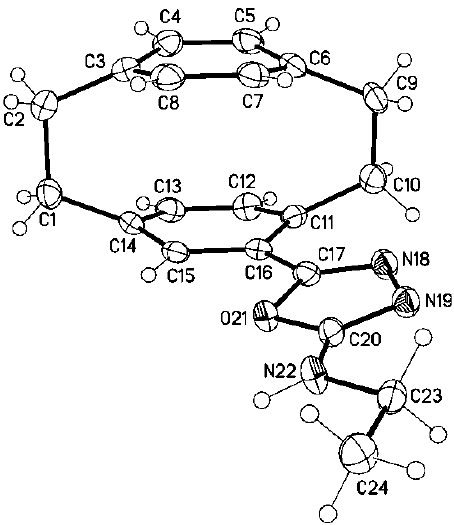
Figure 9. Molecular structure of compound 13c identified according to the IUPAC nomenclature as 5-(1,4(1,4)-dibenzenacyclohexaphane-12-yl)- N -ethyl-1,3,4-oxadiazol-2-amine (displacement parameters are drawn at a 50% probability level).